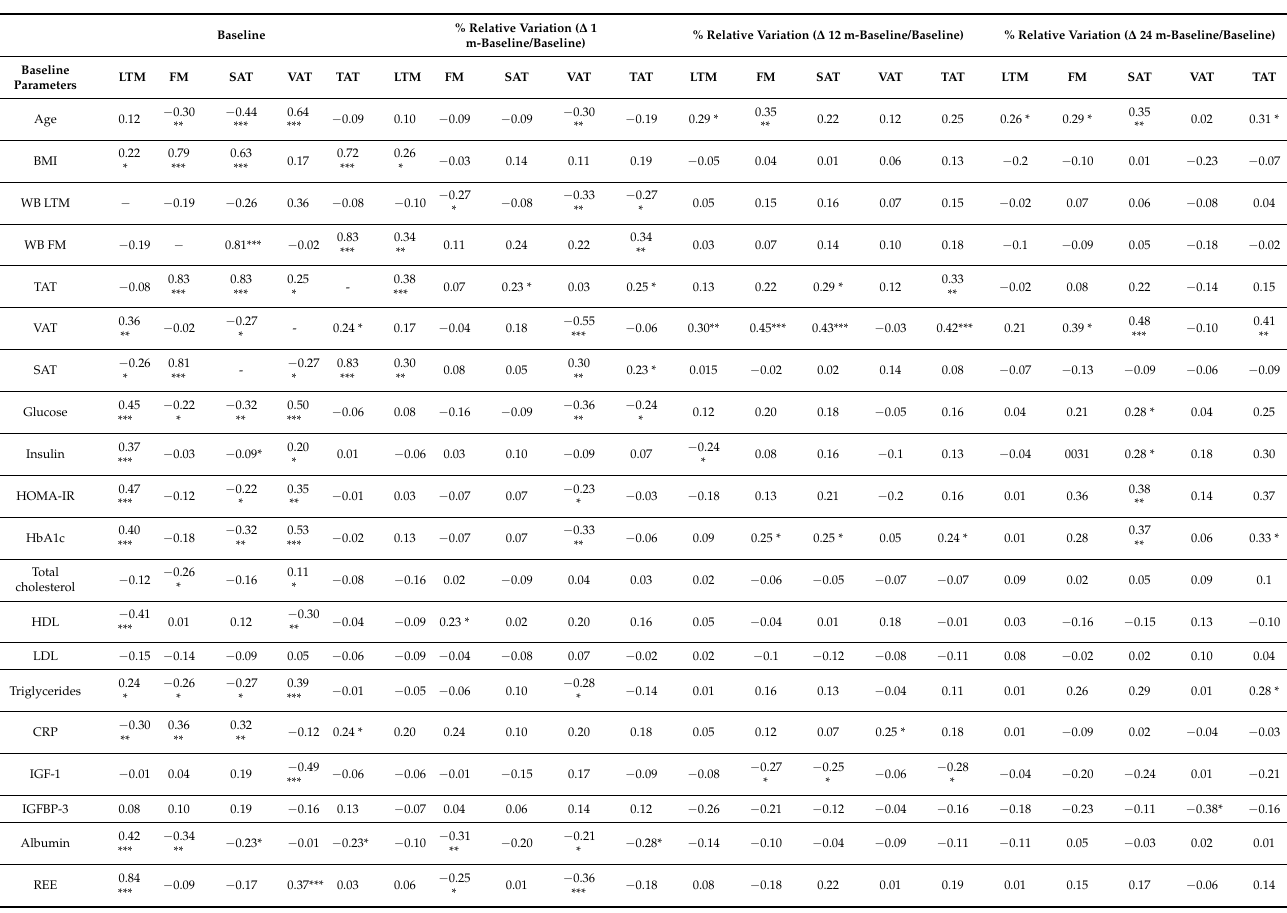
Table 5. Correlation between preoperative characteristics and basal or variations in body composition